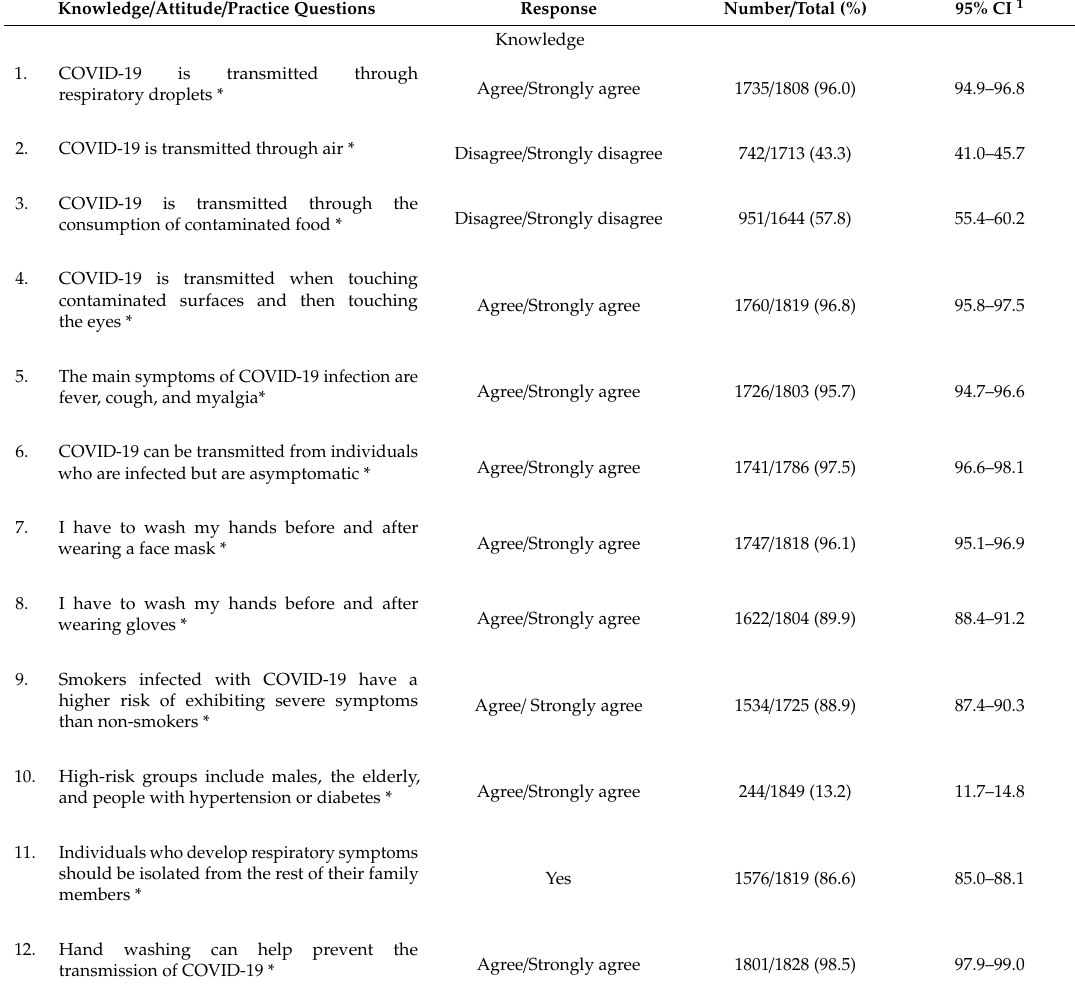
Table 1. Knowledge, attitudes, and practices reported by respondents in Greece during the